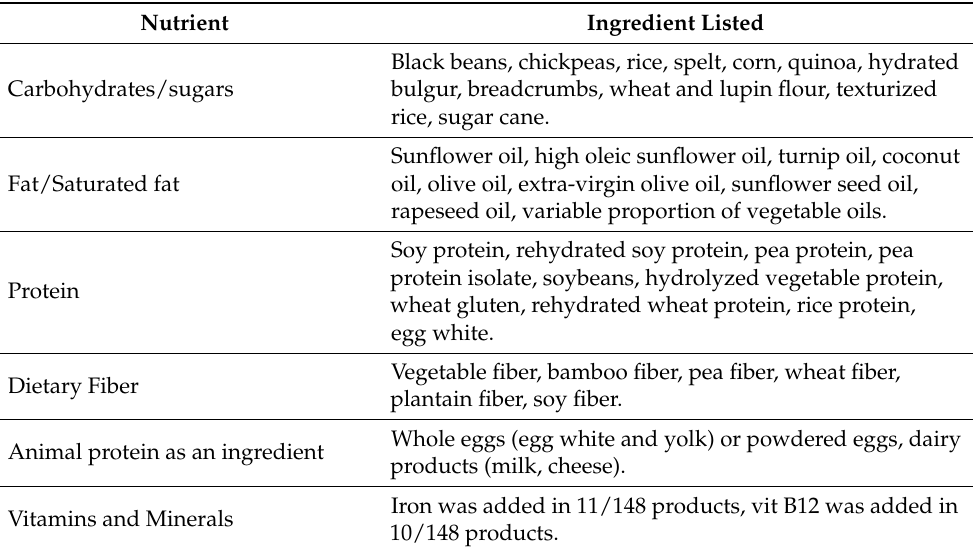
Table 4. Ingredients in plant-based meat alternatives contributing to key